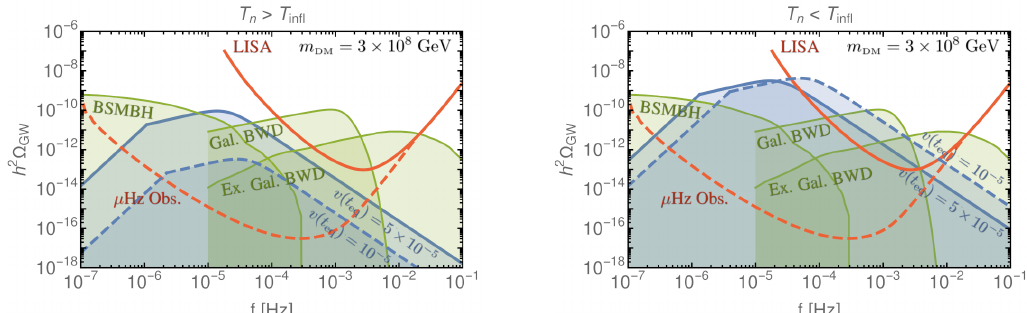
Figure 3: The solid (dashed) blue lines show the predicted gravitational wave spec- = 3 × 10 8 GeV, c = 10 − 2 , λ = 1, trum for the PT corresponding to a DM mass m vac DM ) at the current limit of m = 5 keV (future limit of m = 15 keV). and v ( t eq WDM WDM ≈ 40 GeV ( T ≈ 90 GeV), in the The former (latter) corresponds to a PT with T RH RH > T ≈ 50 GeV ( T ≈ 150 GeV), in the case T < T case T , and with T . In n n infl infl RH RH both cases lower (higher) DM masses would correspond to lower (higher) reheat- = ing temperatures and lower (higher) peak frequencies. We have assumed β H